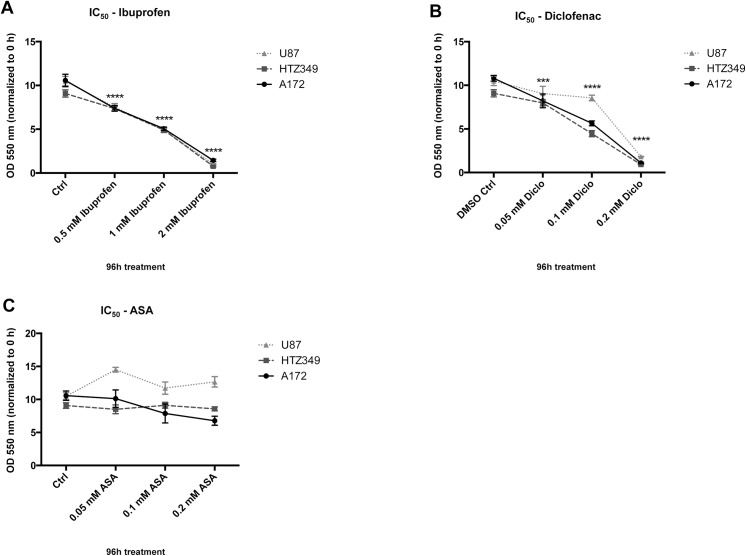
IC50 is distinct for diclofenac, ibuprofen, and ASA.Concentration-dependent cytotoxicity was investigated by treating the glioma cell lines HTZ-349, U87MG, and A172 in absence or presence of increasing concentrations of (A) ibuprofen (0.5–2.0 mM), (B) diclofenac (0.05–0.2 mM), or (C) ASA (0.05–0.2 mM) and DMSO as control in corresponding concentrations. The assays showed a significant linear concentration-dependent decrease of cell viability, which significantly differed between (A) ibuprofen (IC50, 1 mM) and (B) diclofenac (IC50, 0.1 mM). In contrast, (C) ASA had no significant effect on cell proliferation with given concentrations. Statistics: 95% CI, *** = 0.001 < p ≥ 0.0001, **** = p ≤ 0.0001.